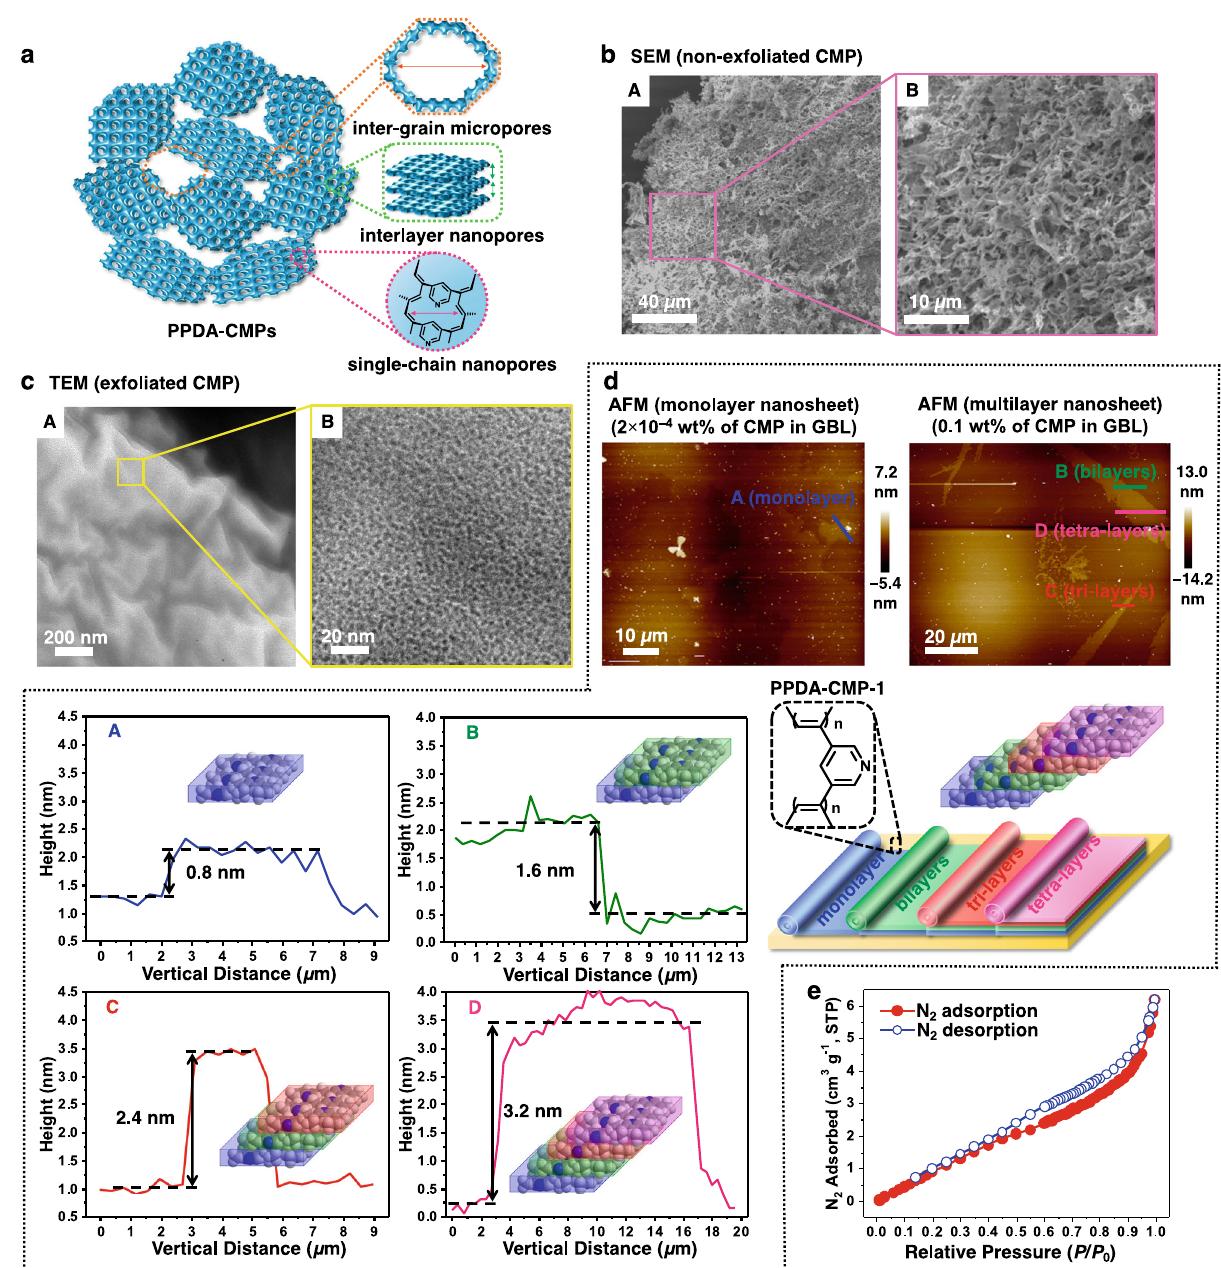
Fig. 2 | Porous structures, 2D exfoliated structures, and BET analysis of PPDA- CMP.a SchematicillustrationofthreetypesofporesinCMPs. b SEMimagesofnon- exfoliatedPPDA-CMP-1showinginter-grainmicropores. c TEMimagesofexfoliated PPDA-CMP-1 (at 2×10 – 4 wt% of CMP in GBL) showing surface (image A ) and single- chain nanopores (zoom-in image B ) at the outermost layer of CMP. d AFM images